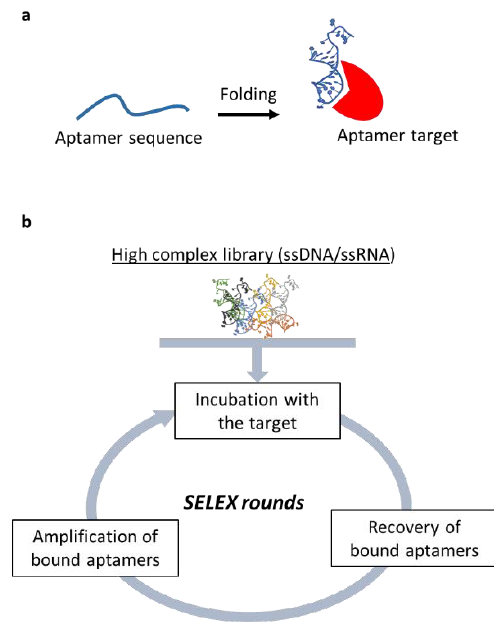
Figure 3. Nucleic acid-based aptamers. ( a ) Schematic representation of aptamer-target binding that depends on aptamer folding. ( b ) The SELEX (Systematic Evolution of Ligands by EXponential enrichment) process permits to select aptamers from high complex library of a random oligonucleotides through repeated rounds of binding, partitioning, and amplification of bound oligonucleotides.